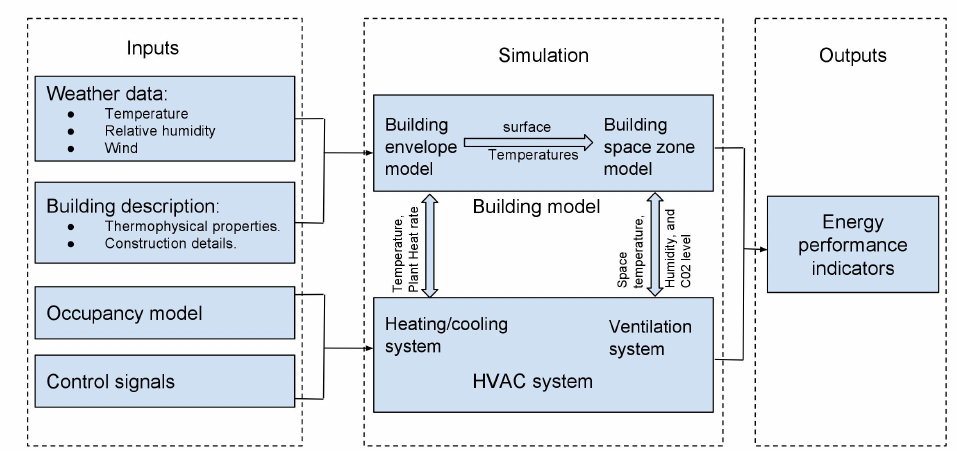
Figure 5. Development of a thermal-network model for a building zone